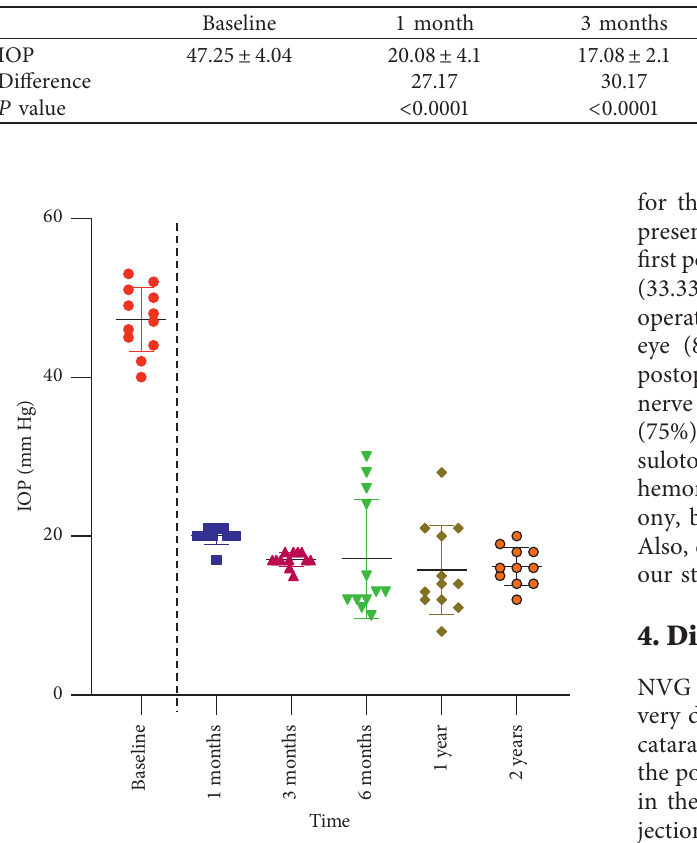
Figure 2: Intraocular pressure changes